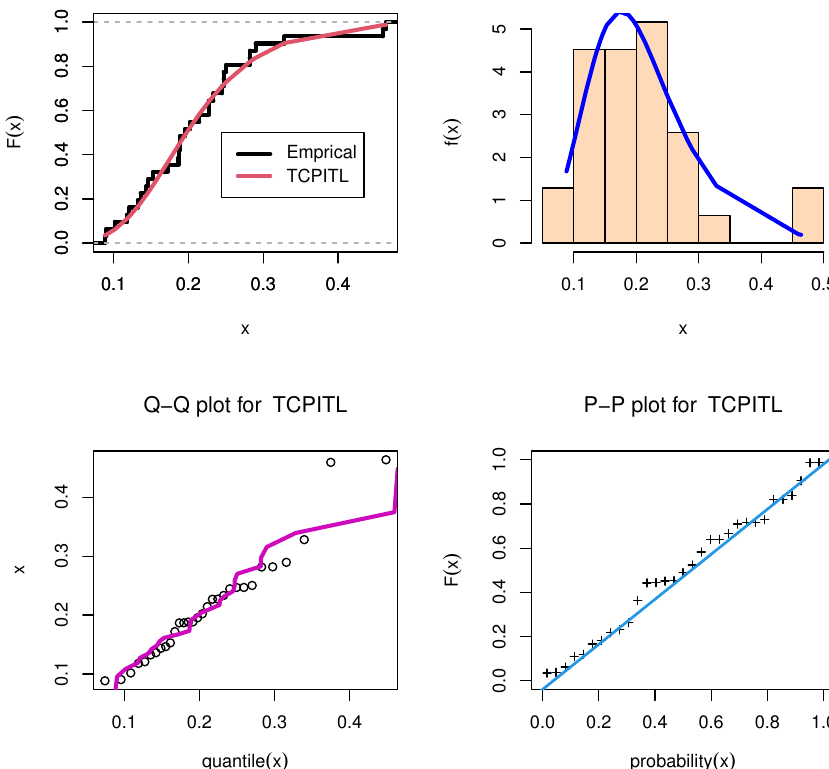
Figure 8. Fitted PDF for Senegal COVID-19 data set